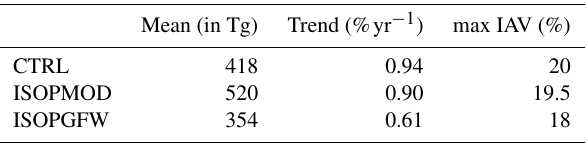
Table 5. Global mean annual isoprene emissions (in Tg), trend (%yr − 1 ), and maximum interannual variability (IAV, defined as dif- ference between global maximum and global minimum, in %) for the 2001–2016 period in CTRL, ISOPMOD, and ISOPGFW simu- lations. Mean (in Tg) Trend (%yr − 1